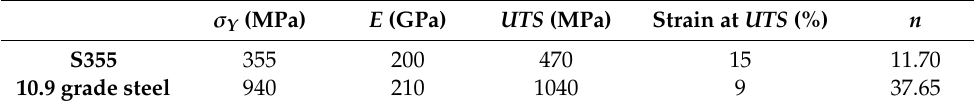
Table 1. Material properties employed in numerical simulations.